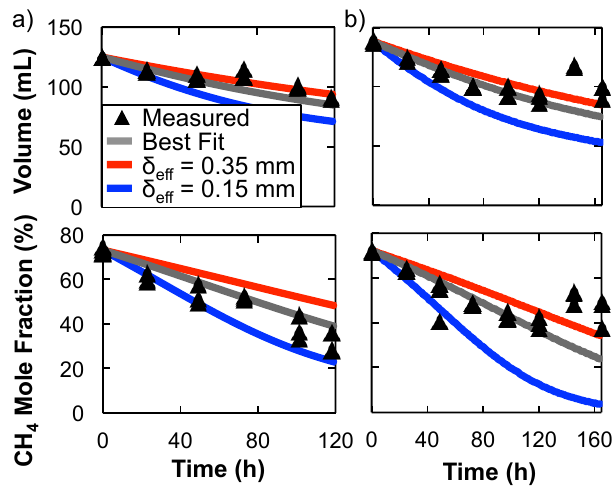
Figure 4. Modeled and measured volume and CH 4 mole fraction of gas inside ice-bubble mesocosm chambers in the spring 2011 (a) and fall 2011 (b) trials. Values of δ eff = 0 . 25 and 0.27mm were found to give the best fits to volume and composition measurements for the spring and fall trials, respectively. Values of δ eff = 0 . 35 and 0.15mm encompassed the range of uncertainty in these measure- ments, so they were used in sensitivity analyses (Sect.